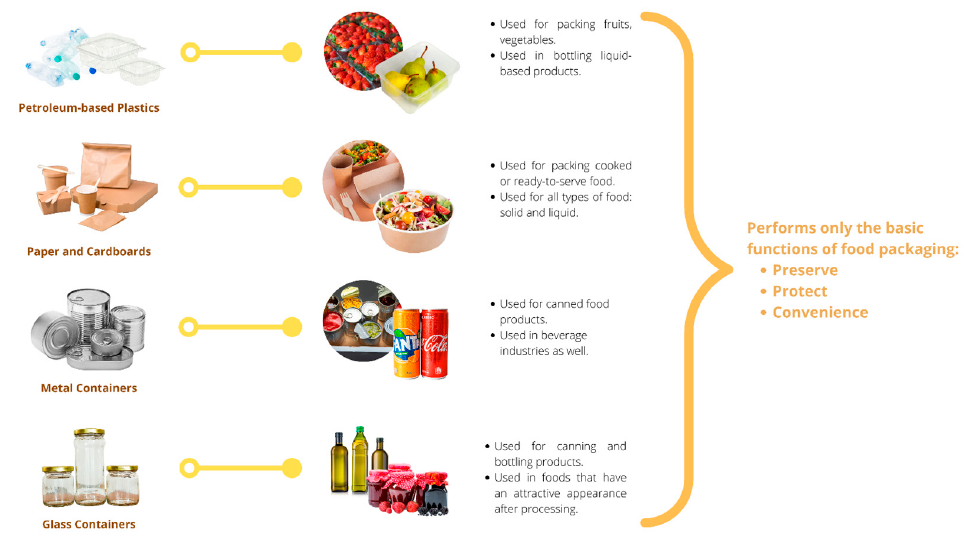
Figure 1. Application of conventional packaging.